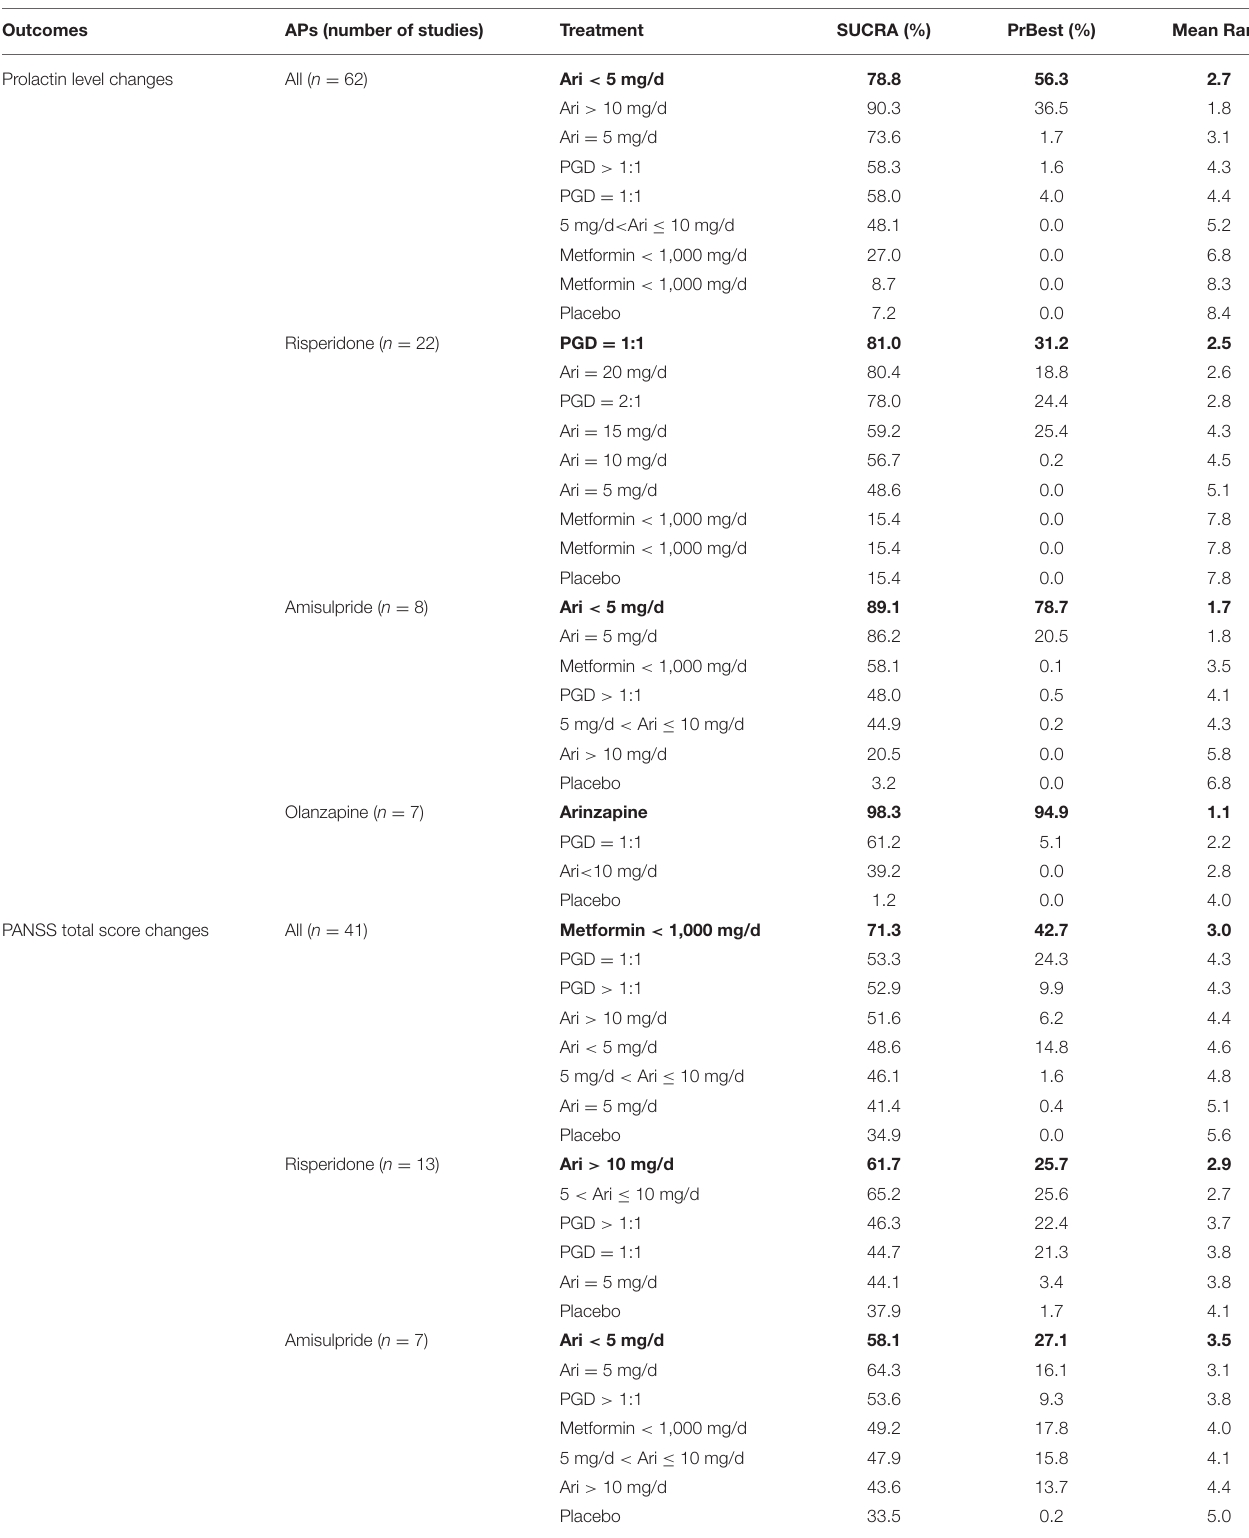
TABLE 3 | Rankings of adjunctive aripiprazole, metformin and PGD in reducing prolactin levels in schizophrenia. Outcomes APs (number of studies) Treatment SUCRA (%) PrBest (%) Mean Rank Prolactin level changes